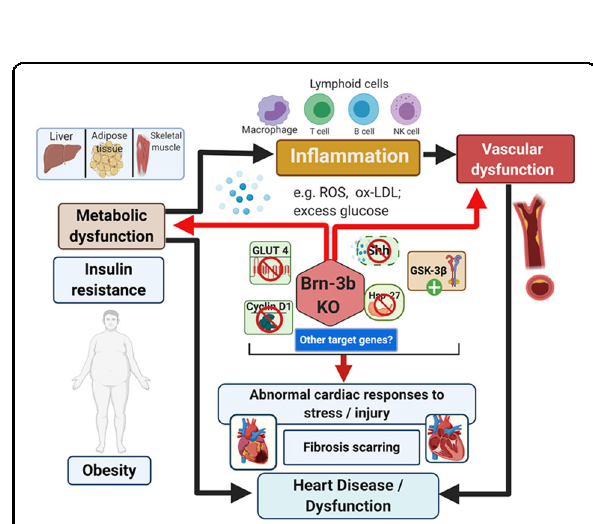
Fig. 5 Schematic diagram to show proposed effects by which loss of Brn-3b and its target genes can cause deregulated function in different tissues. Loss of Brn-3b and its target genes may directly or indirectly contribute to adverse effects in insulin-responsive tissue (skeletal muscle, adipose tissue, liver), vascular smooth muscle cells (VSMC) in blood vessels or cardiomyocytes of the heart. Direct effects could arise if the loss of Brn-3b and its target genes are necessary for controlling normal function in speci fi c tissues. In contrast, indirect effects may result from crosstalk between different systemic effects with metabolic dysfunction, caused by loss of Brn-3b giving rise to pro-in fl ammatory milieu e.g. reactive oxygen species (ROS), oxidative low-density lipoprotein (Ox-LDL), which, in turn, trigger adverse changes in the heart and vasculature.